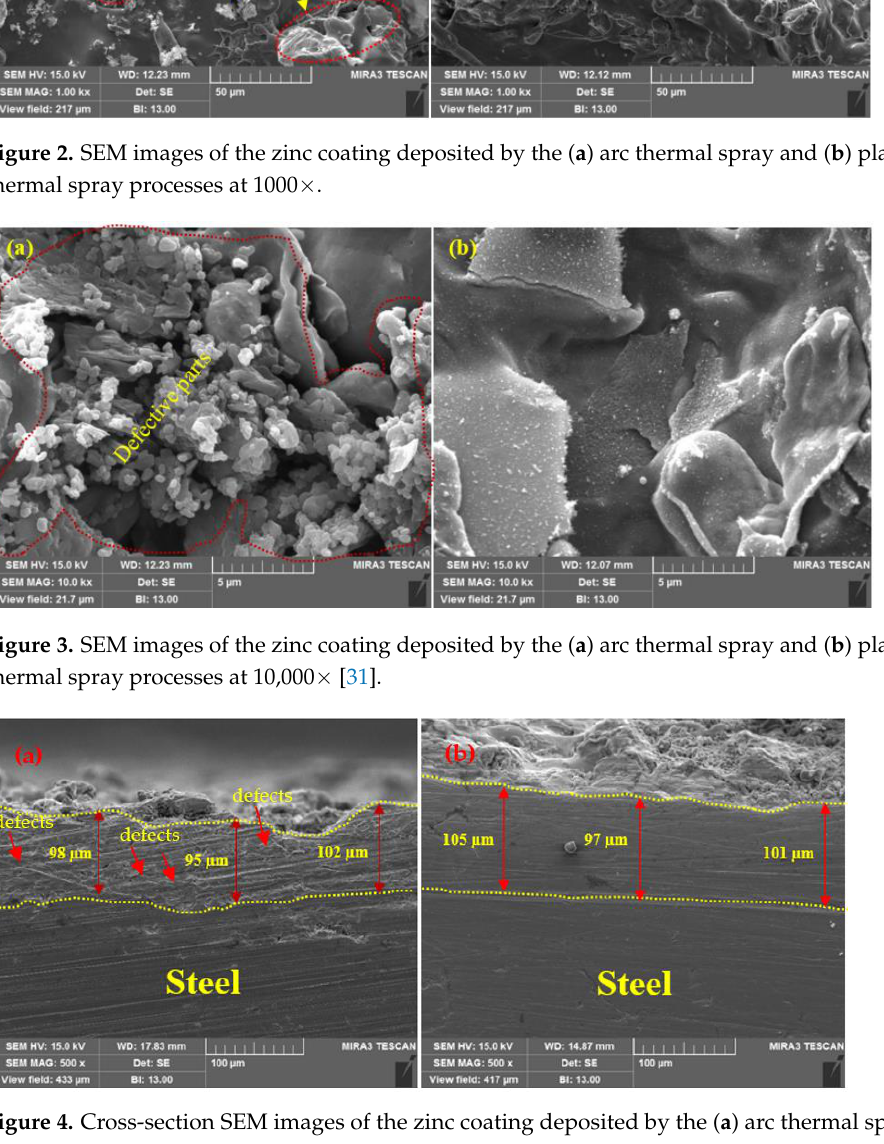
Figure 4. Cross-section SEM images of the zinc coating deposited by the ( a ) arc thermal spray and ( b ) plasma arc thermal spray processes at 500 × ( b ) plasma arc thermal spray processes at 500×. Table 3. EDS analysis of the Zn coating deposited by different processes.